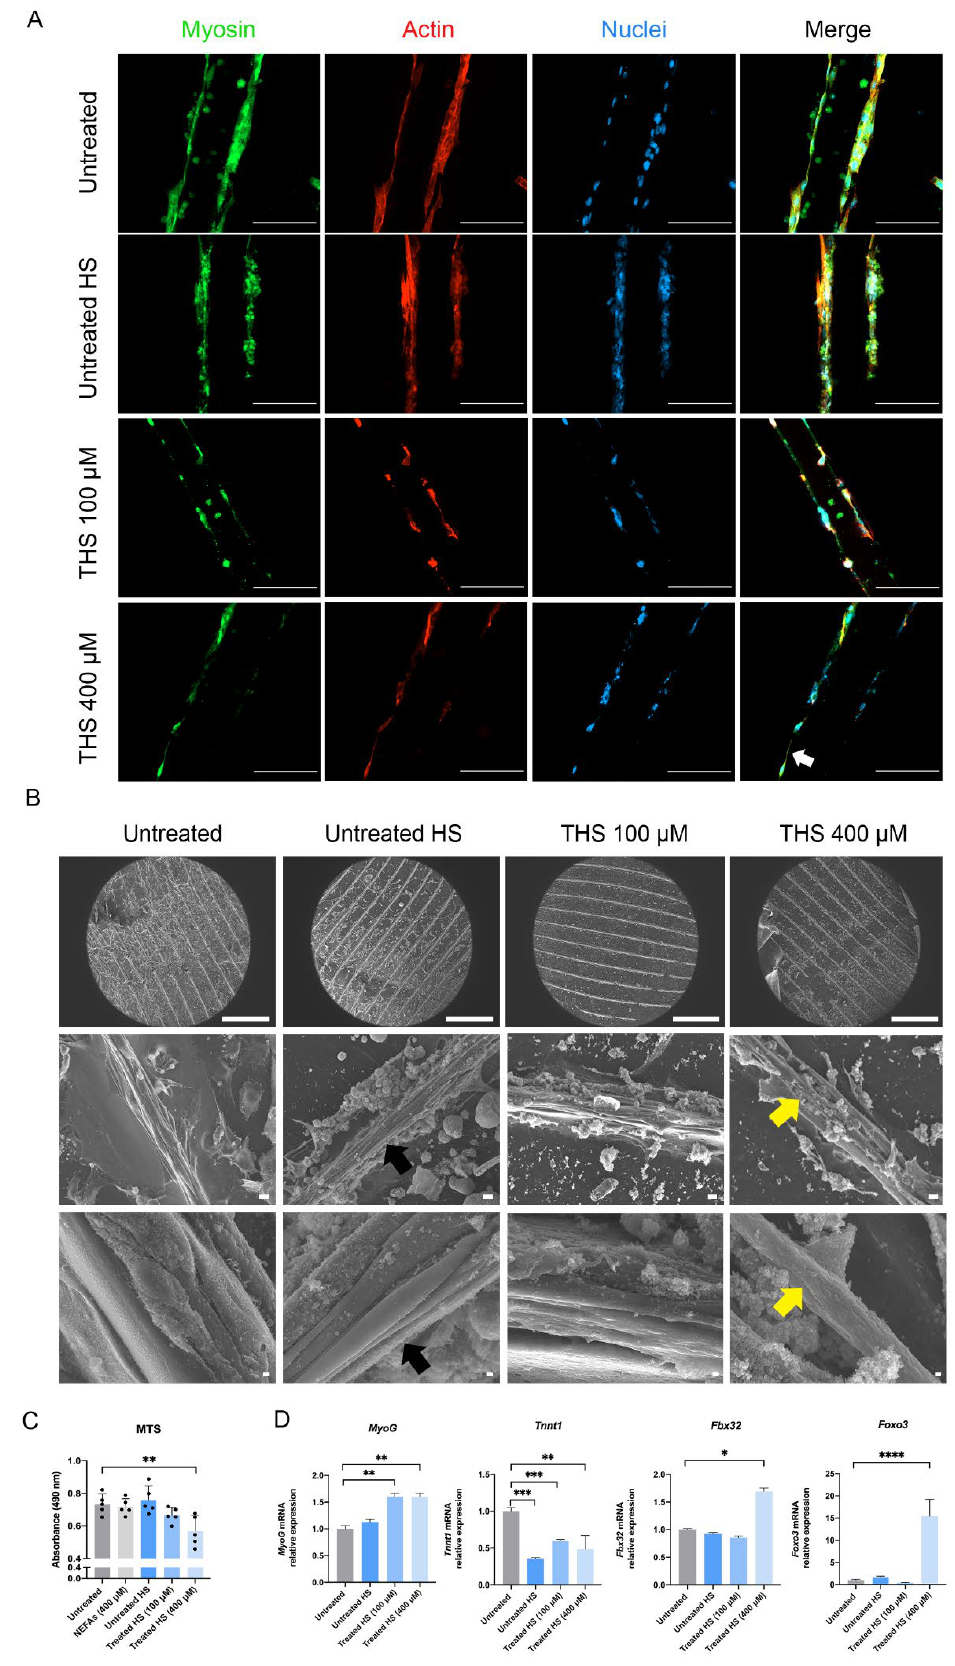
Figure 5. Effect of fatty hepatocytes’ supernatant on 3D skeletal muscle tissues. ( A ) Confocal